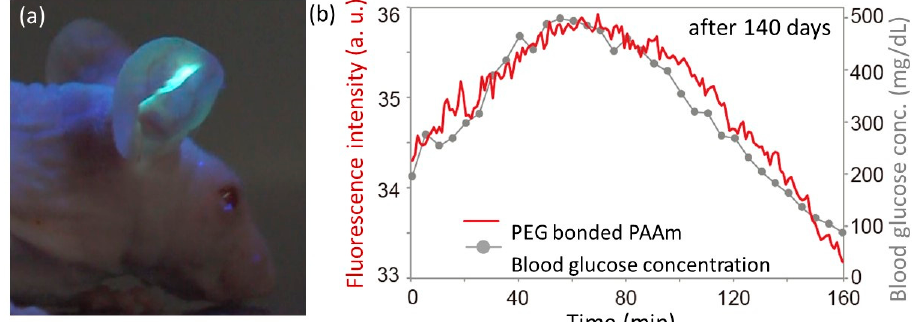
Figure 4. ( a ) Fluorescence hydrogel with boronic acids under the skin of mouse ear. The hydrogel glows through skin. ( b ) The fluorescence intensity of hydrogels responded to blood glucose concentration continuously after 140 days from implantation. Modified figures from those in Ref. [47].